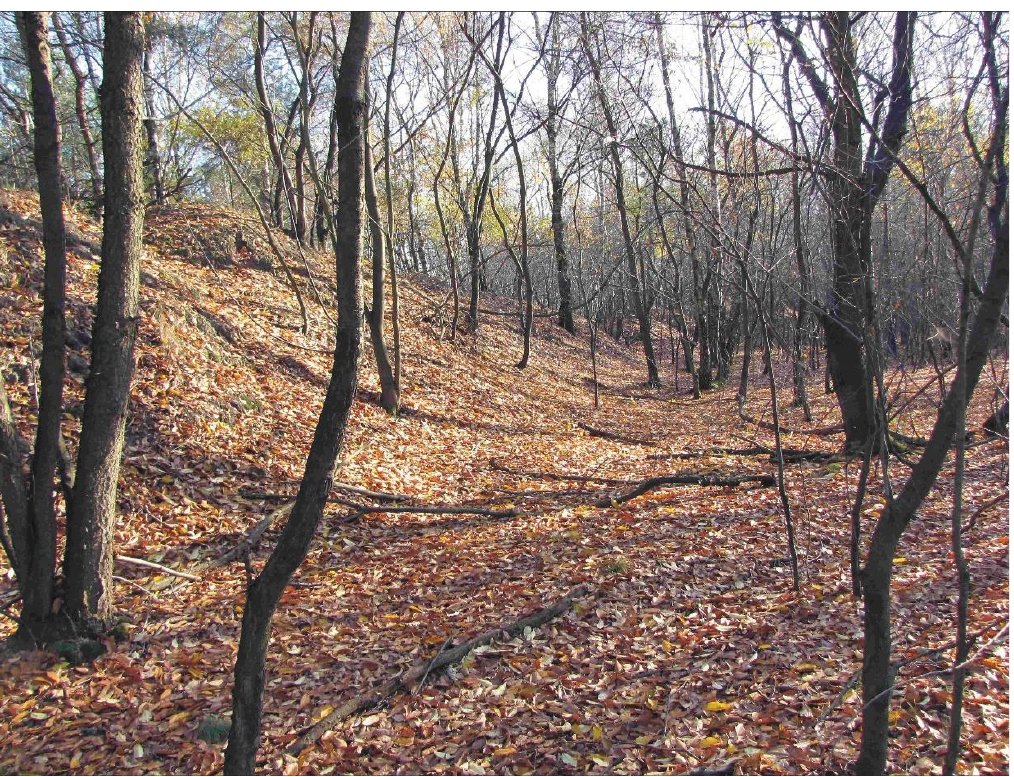
Figure 8. A pile of humus overburden removed from a sand mine field (photo: J.M. Waga).